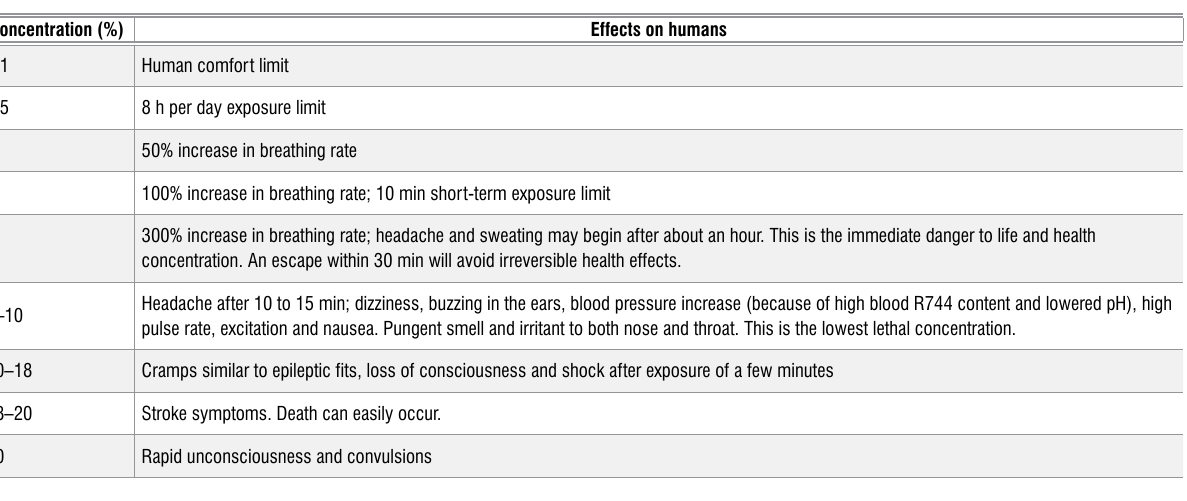
Effect on humans of R744 at various concentrations 1,21